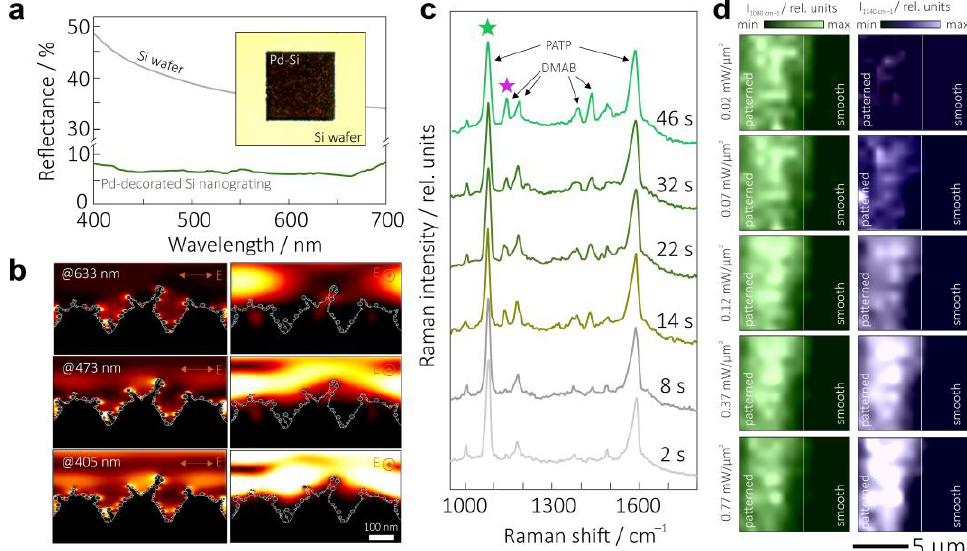
Figure 4. ( a ) Reflectance spectra of Pd-decorated Si nanograting and pristine Si wafer. The following parameters were used for grating fabrication: F = 0.1 J/cm 2 , N = 25, aqueous solution with 10 −3 M of H 2 PdCl 4 . Inset shows the microscopic optical image of the laser-patterned (100 × 100 µm 2 ) Si surface. ( b ) Normalized EM-field amplitude E/E 0 in the vicinity of Pd NP-decorated Si nanograting excited by a plane wave with wavelengths of 405, 473, and 633 nm polarized perpendicular (left column) or parallel (right column) to the nano-trench orientation. ( c ) Representative series of time-resolved SERS spectra showing photocatalytic transformation of PATP to DMAB product upon continuous irradiation of the probe molecules adsorbed on the Pd-decorated Si nanogratings. Total laser exposure time is indicated near each spectrum. ( d ) Energy-resolved SERS maps (10 × 10 µm 2 ) showing intensity distribution of PATP- (1080 cm −1 ) and DMAB-related (1140 cm −1 ) bands near the interface between the Pd-decorated Si nanogratings and smooth Si surface. The maps were measured at various laser intensities ranging from 0.02 to 0.77 mW/µm 2 at an accuracy of 250 nm and signal accumulation time of 0.5 s per spot.